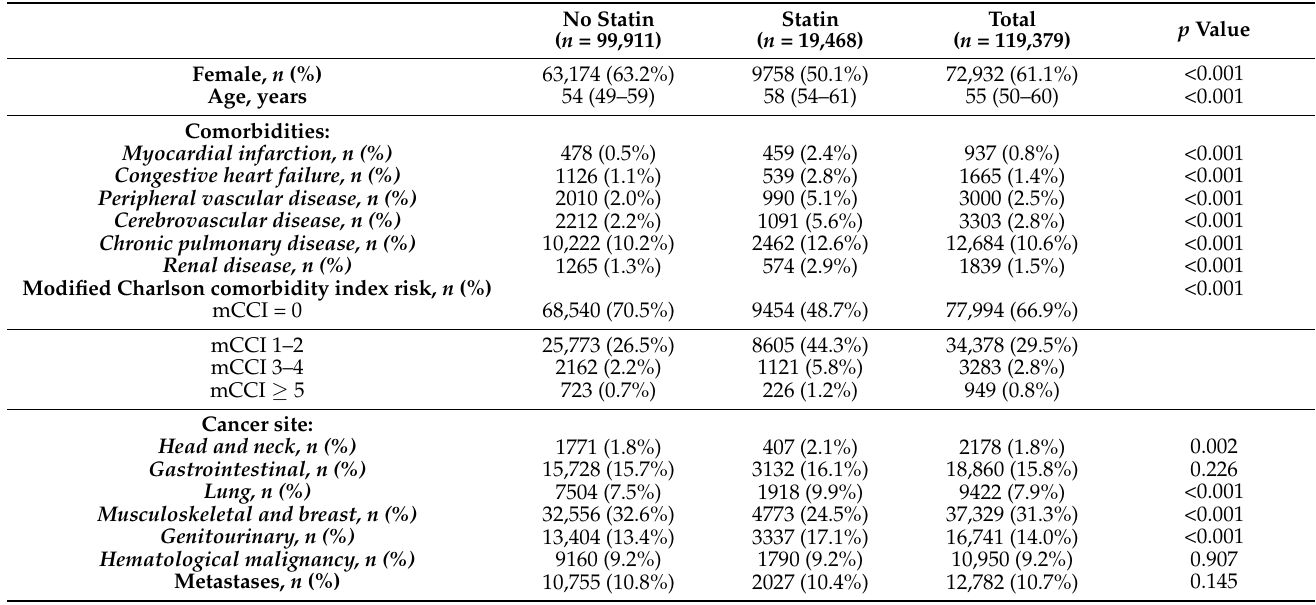
Table 1. Characteristics of the population and comparison of patients according to statin